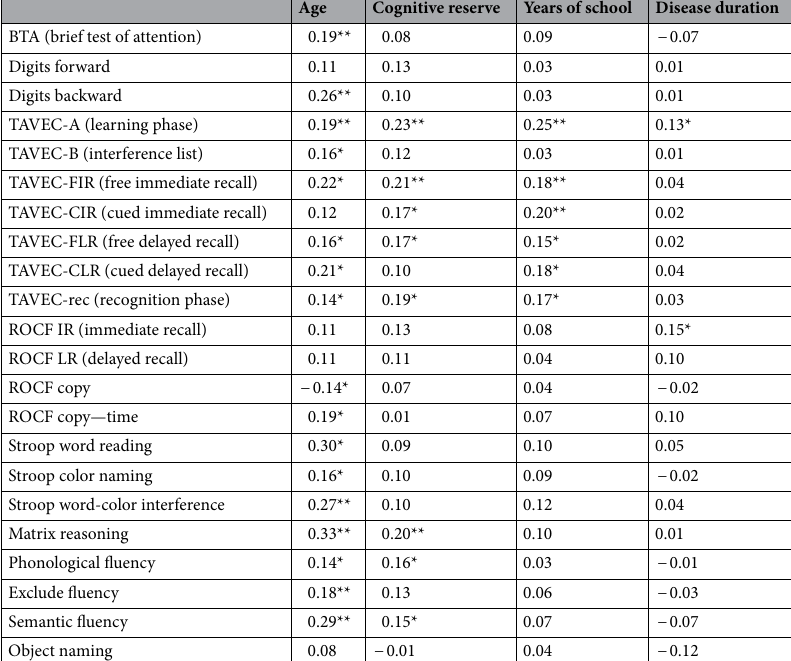
Table 2. Correlations of cognitive performance with sociodemographic and disease duration. *p < 0.05 , **p < 0.01